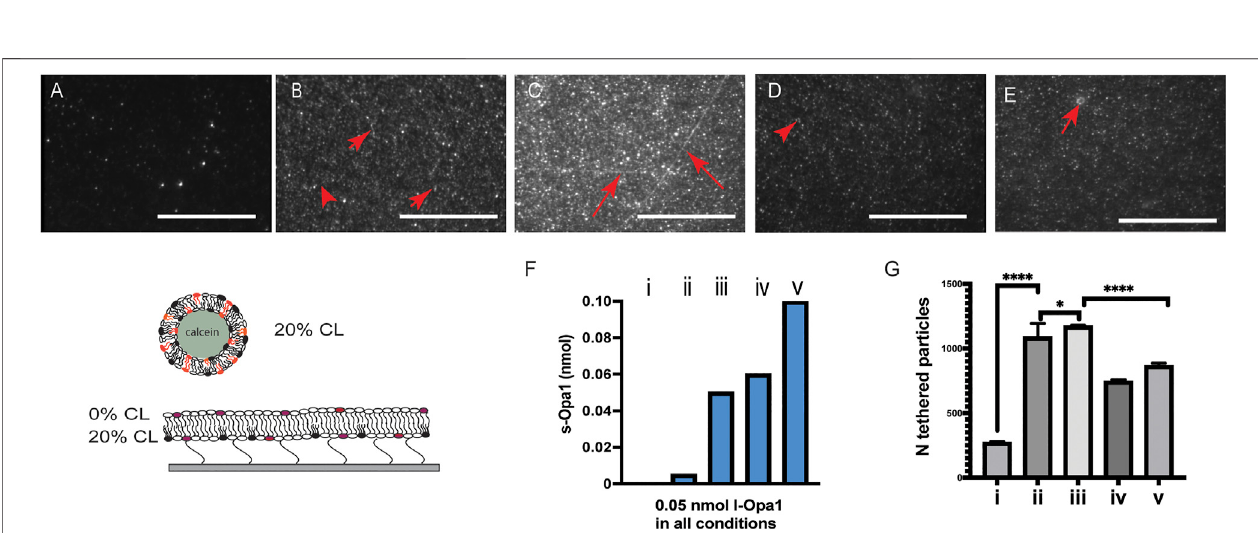
FIGURE3| Effect ofs-Opa1 onproteoliposome tethering toanasymmetric CL bilayer. (A) In thepresence ofGTP, fewl-Opa1proteoliposomes are tethered toan asymmetric CL bilayer containing l-Opa1. Upon s-Opa1 addition, proteoliposome tethering increases signi fi cantly. Panels (B – E) show representative images varying l-Opa1ands-Opa1concentrationshowninpanel (F) asi-iv.l-Opa1concentrationwas fi xedat0.05 nmolinallconditions.Scalebar,20 µm.Redarrowsindicatetubular structures tethered to the bilayer. (G) Quanti fi cation of the number of proteoliposomes tethered to the bilayer, based on 10 – 20 random points in each experiment, for a total of three to fi ve different experiments. Data were analyzed using t -test. The illustrations indicate lipid distribution in the membrane, with both bilayers containing reconstituted l-Opa1.